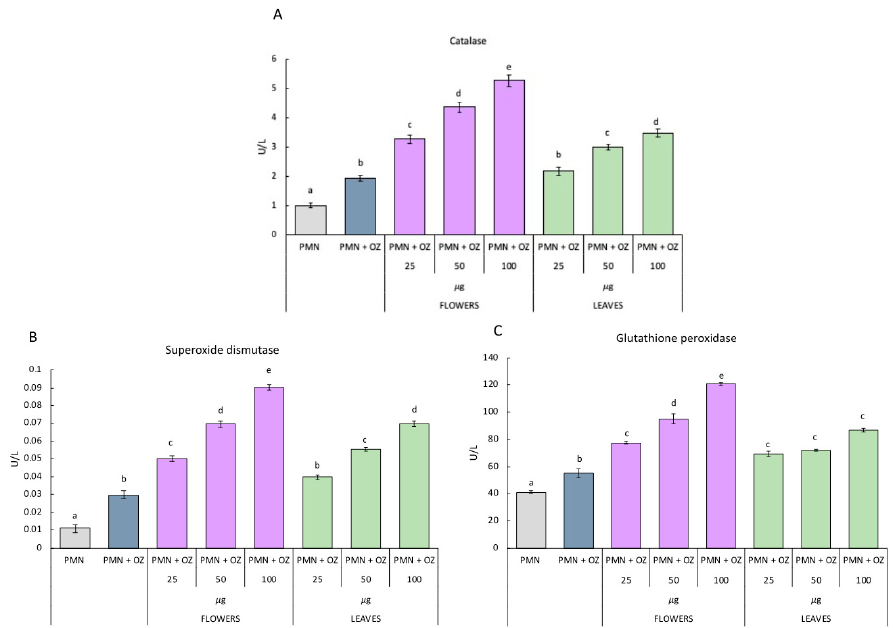
Figure 4. Activities of antioxidant enzymes: catalase ( A ); superoxide dismutase ( B ) and glutathione peroxidase ( C ) in polymorphonuclear cells treated with essential oils of P. ferulacea at the concentrations of 0, 25, 50, 100 µg/mL with or without OZ (0.5 mg mL − 1 ). Data were presented as mean and standard error and they were analyzed with a paired t -test. Bars not accompanied by the same letter were significantly different at p < 0.05.